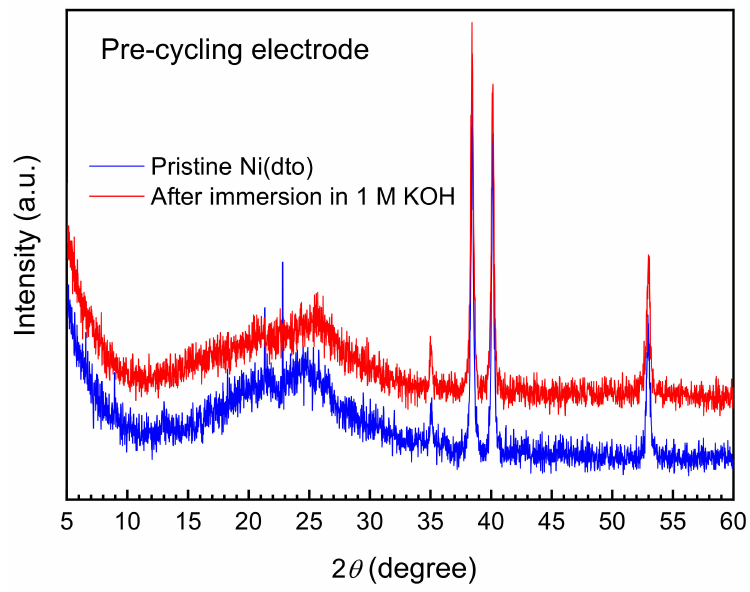
Figure 5. The powder XRD of pre-cycling Ni(dto)-DH/C electrodes using Ti foil coated by Ni(dto).